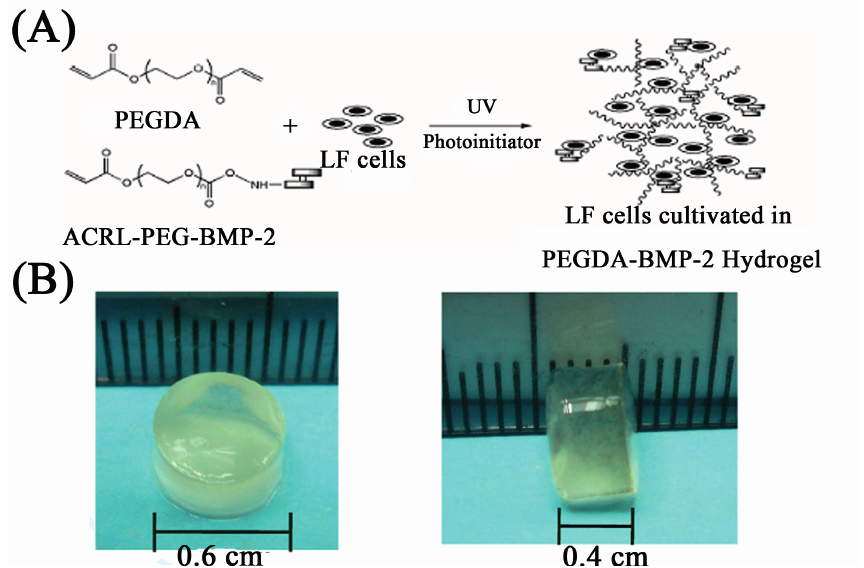
Figure 10. The scheme of LF cells cultivated in photo-responsive hydrogel ( A ) and size ( B ), of photo-responsive hydrogel using in this